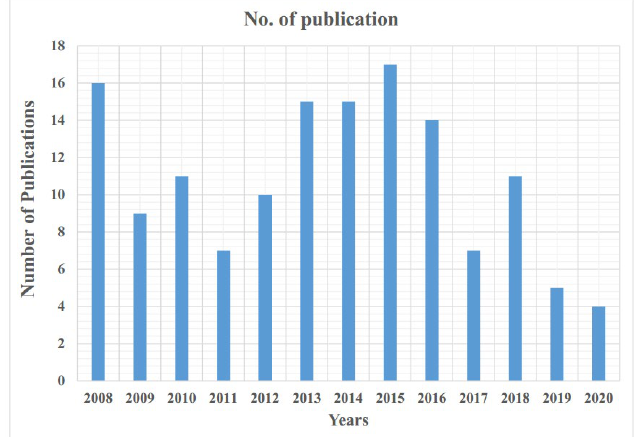
Figure 2. State of the Art of SCED